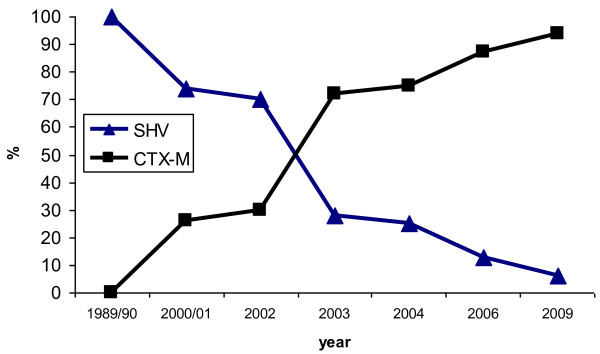
Evolution of SHV and CTX-M ESBL type incidence during the study period.